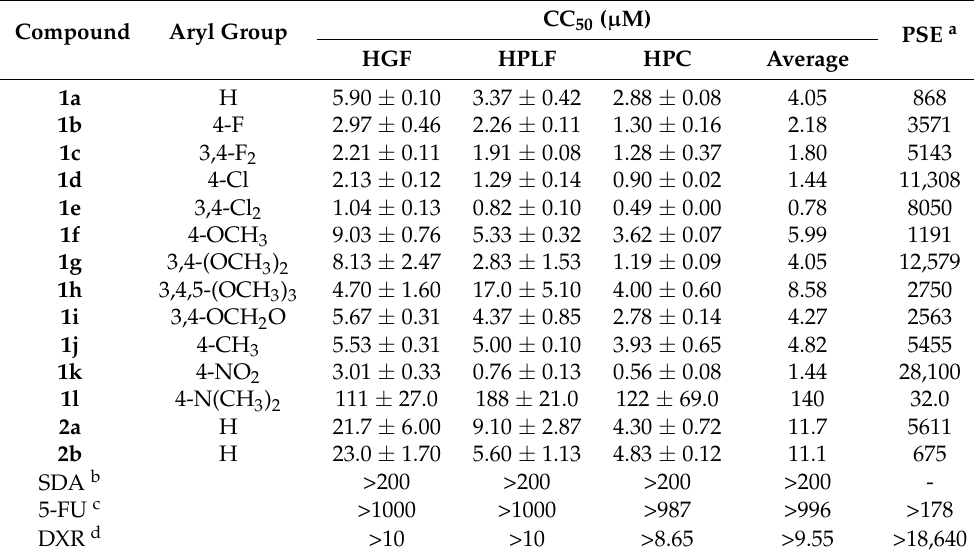
a The letters PSE refer to the potency–selectivity expression. These values are the products of the reciprocal of the average CC 50 values of the compounds towards Ca9-22, HSC-2, HSC-3, and HSC-4 cells and the average SI values × 100. Each CC 50 value represents mean ± S.D. of triplicate assays. b The letters SDA refer to sodium